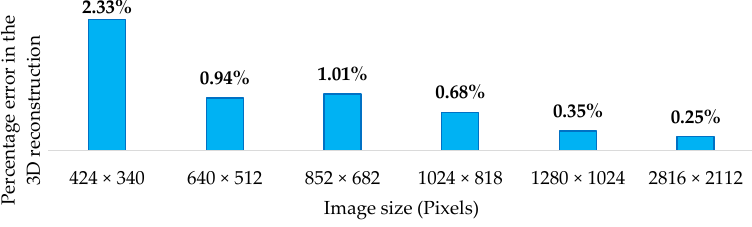
Figure 7. 3D reconstruction error as a function of the image size.